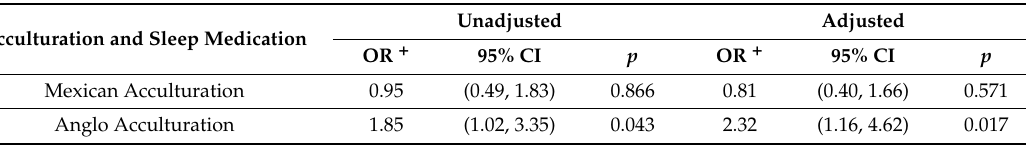
Table 3. Association between acculturation and sleep medication use among individuals of Mexican descent at the US–Mexico